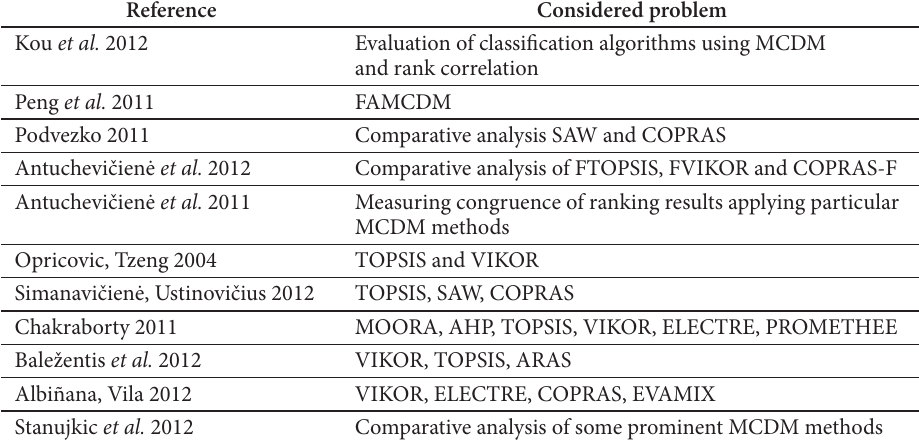
Table 5. Comparative analysis of MCDM methods